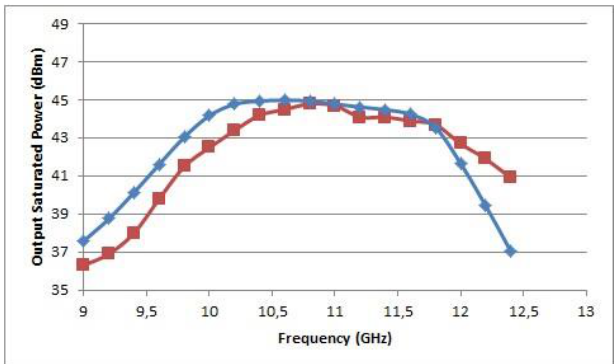
Figure 14: Saturated power output for amplifier operating between 10-12 GHz. Blue line: simulation, red line: